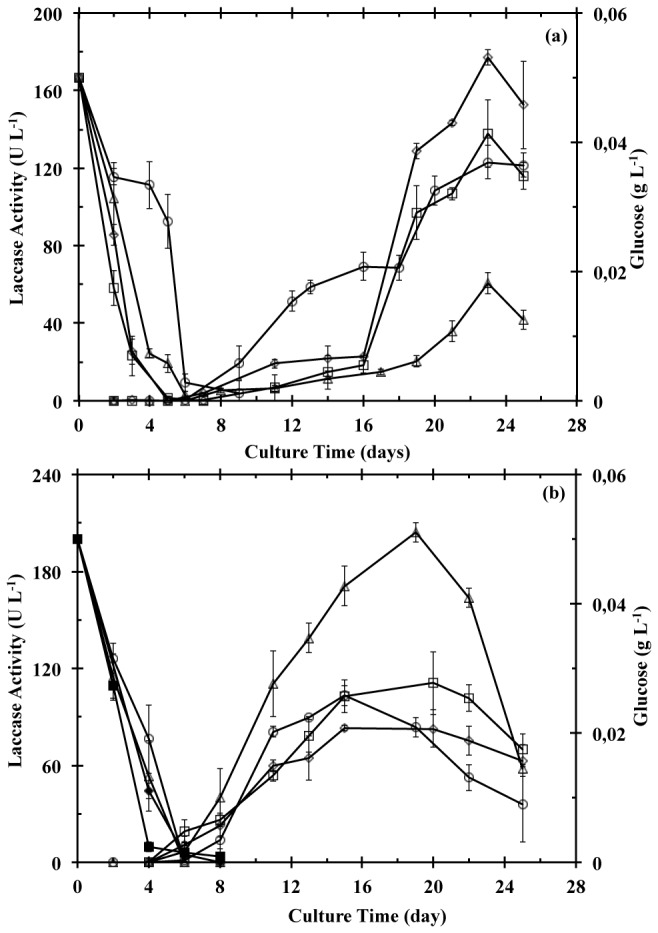
Laccase activity profiles during

T

. pubescens
 CBS 696.94 culture under SmC (a) and SSC (b) on coffee husk.Culture media was enriched with different copper concentrations: 0 (Δ), 0.5 (□), 2 (○) and 5 (◊) mM, and laccase activity was determined by using syringaldazine as substrate. Filled symbols refer to the glucose concentration at the respective copper concentration. All the assays were performed in triplicate.